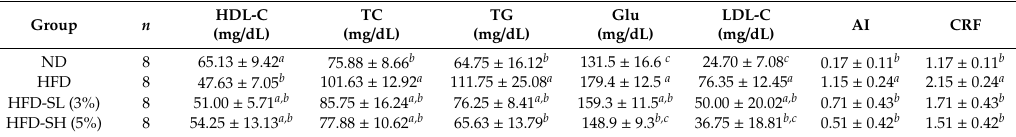
Table 5. E ff ects of the Spergularia marina Griseb powder (SMP) on the serum lipids profiles in HFD-induced obese rats.